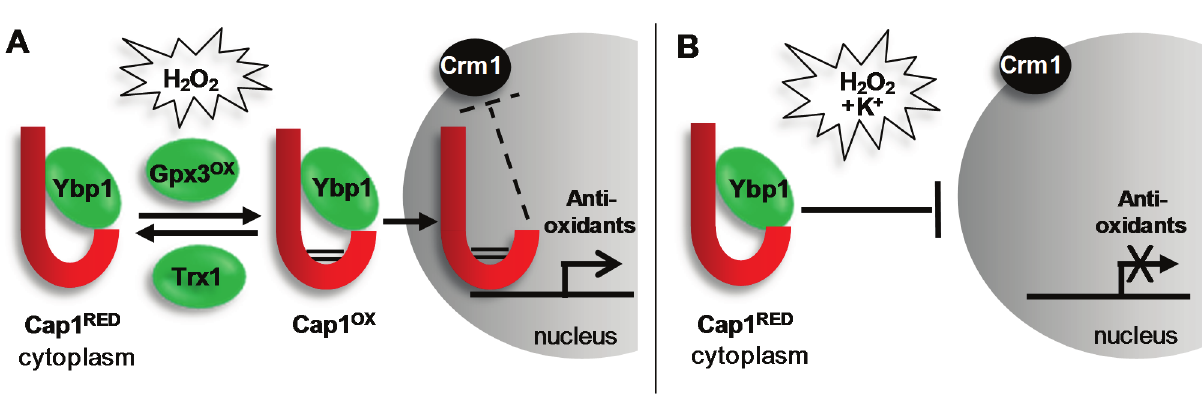
Figure 1. H 2 O 2 -induced activation of Cap1 is inhibited in the presence of cations. ( A ) Exposure of C. albicans to H 2 O 2 promotes the Gpx3/Ybp1-mediated oxidation and activation the Cap1 transcription factor (Cap1 ox ). Cap1 ox can no longer interact with the Crm1 nuclear export factor resulting in its nuclear accumulation, and the subsequent Cap1-dependent induction of genes with antioxidant functions necessary for cell survival. Following cellular adaptation, Cap1 ox is returned to the inactive reduced form (Cap1 RED ) by thioredoxin (Trx1); ( B ) Remarkably, when C. albicans cells are exposed to H 2 O 2 in the presence of cations, Cap1 fails to accumulate in the nucleus and therefore antioxidant gene expression is not induced leading to cell death. This is important as, following phagocytosis, C. albicans is exposed simultaneously to ROS and cationic fluxes. See text for